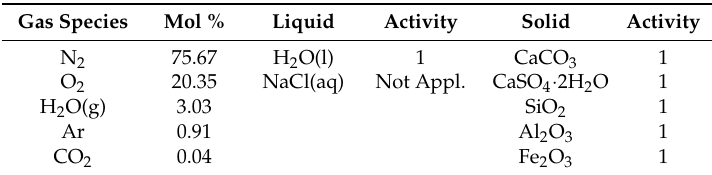
Table 1. Composition of reference environment at 298 K and 1 atm.